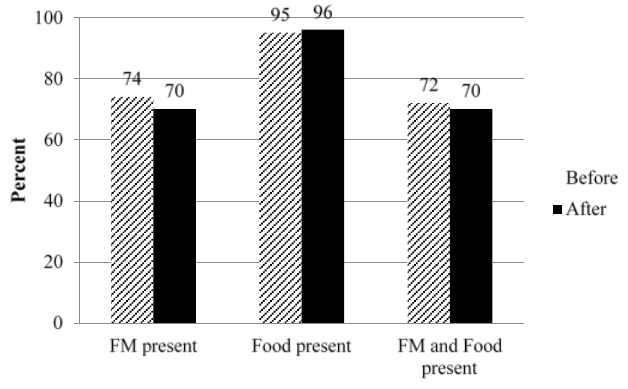
Figure 3. Representation of children’s demonstration of skill set 1 for capturing, at least, one usable image pair ( n = 57) among Sample 1 in Guam during summer 2013.